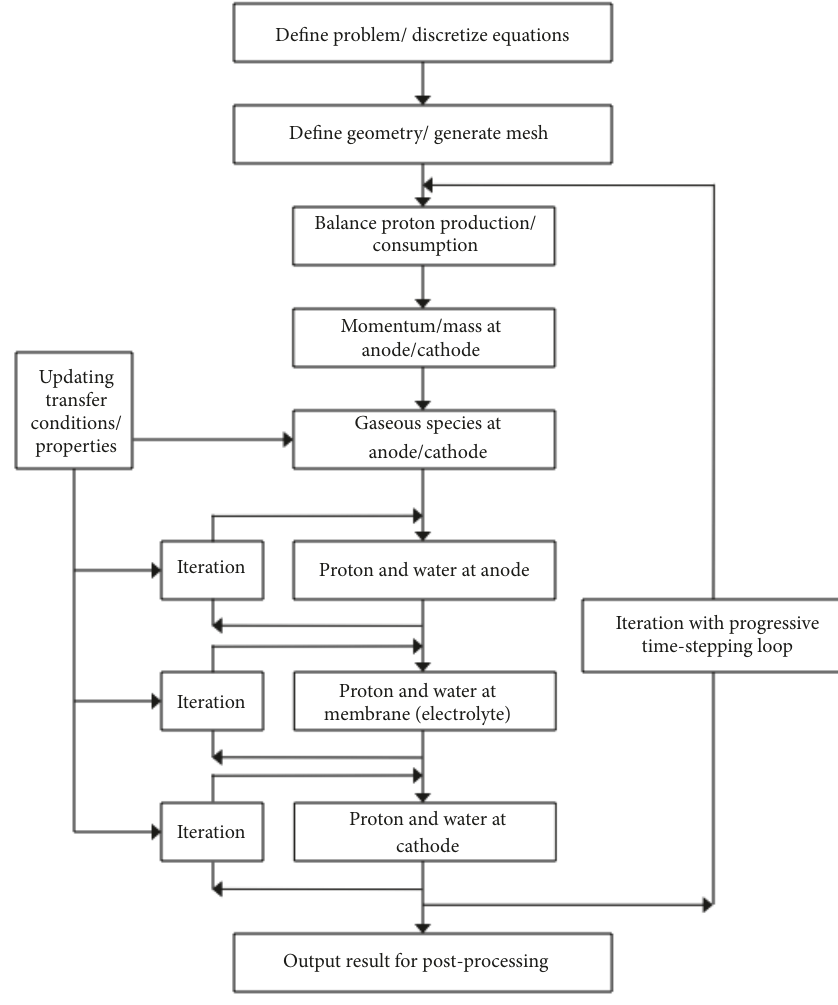
Figure 1: The computational procedure with the time-stepping progressive iteration loop